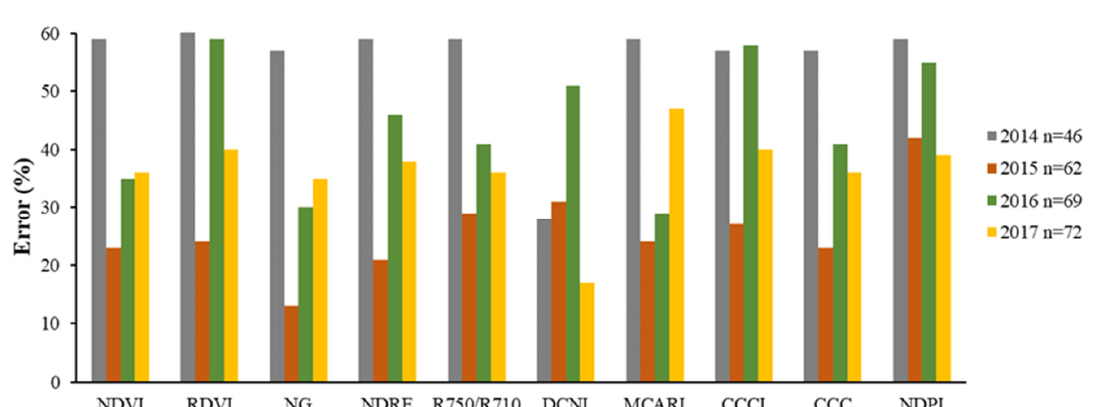
Figure 9. Error of the selected indices in assessing grain N concentration (%) at booting (GS41), over the 4 experimental years. n indicates the number of values used to calculate the error.